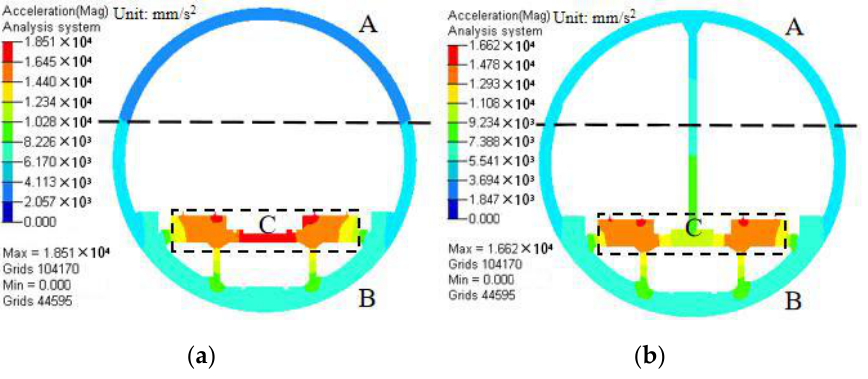
Figure 15. t = 2.45 s, tunnel acceleration response during double-train traffic: ( a ) double-track tunnel; ( b ) double-track tunnel with middle partition wall; zone A is the upper half of the tunnel, zone B is the lower half of the tunnel, zone C is the track bed and surrounding connections.